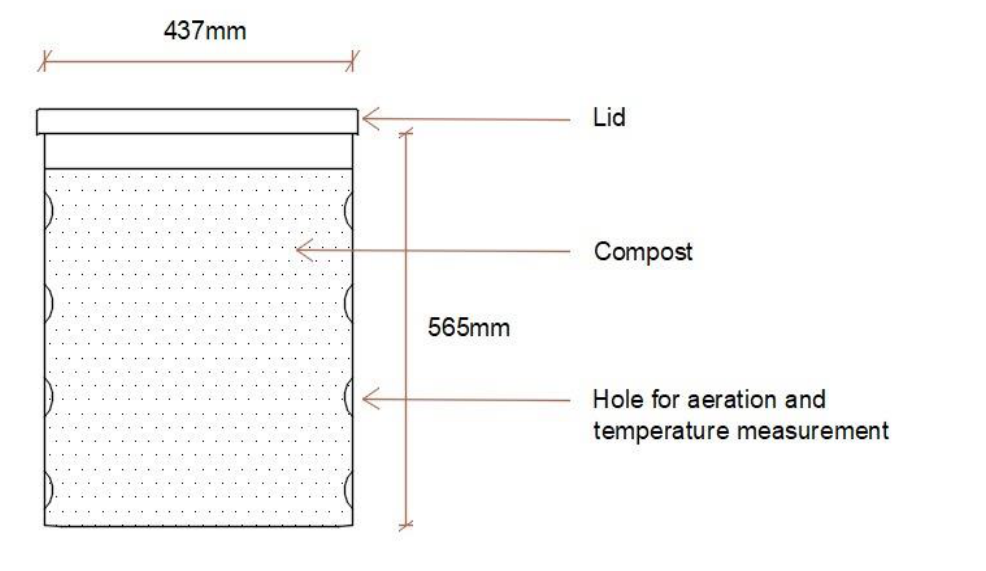
Fig. 1 Schematic diagram of composting system Characterization of the final